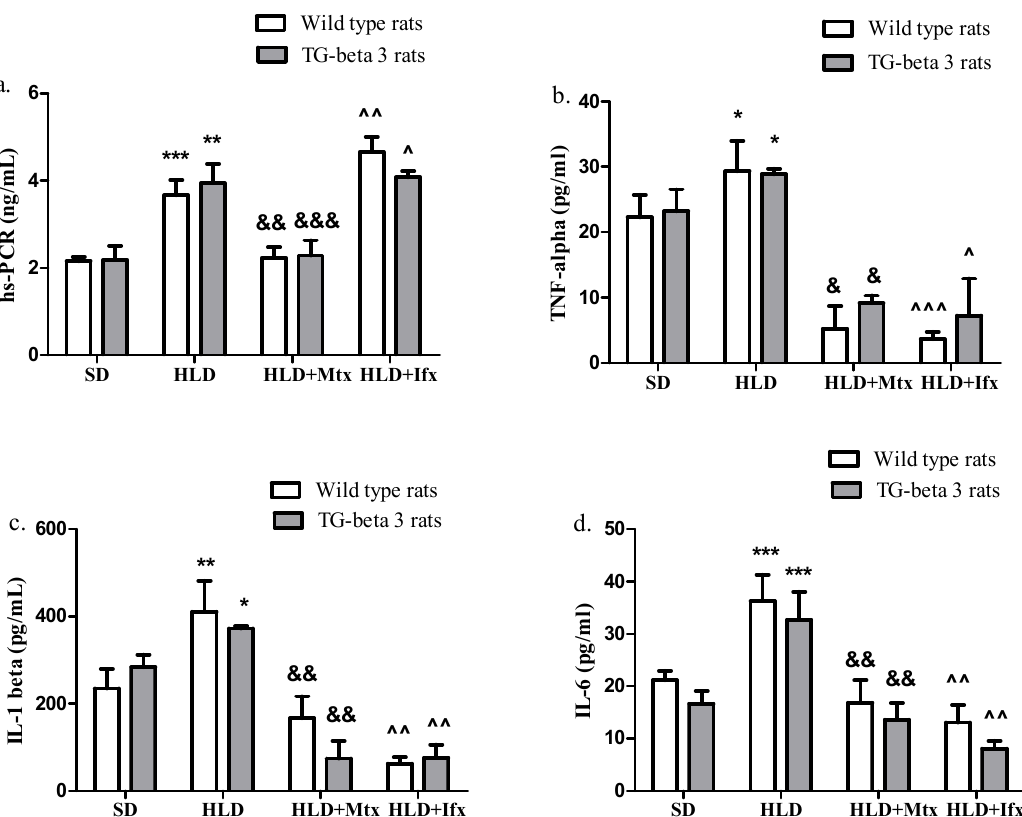
Figure 2. Methotrexate and infliximab effects on inflammation markers. ( a ) High sensitivity reactive protein C (hs-PCR), ( b ) tumor necrosis factor-alpha (TNF-alpha), ( c ) interleukine-1 beta (IL-1 beta), ( d ) interleukine-6 (IL-6). SD—standard diet; HLD—high lipid diet; Mtx-methotrexate; Ifx-infliximab; HLD + Mtx—high lipid diet associated with methotrexate; HLD + Ifx—high lipid diet associated with infliximab. * p < 0.05; ** p < 0.01; *** p < 0.001 HLD versus SD group; & p < 0.05; && p < 0.01; &&& p < 0.001 HLD + Mtx versus HLD group; ^ p < 0.05; ^^ p < 0.01; ^^^ p < 0.001 HLD + Ifx versus HLD group.